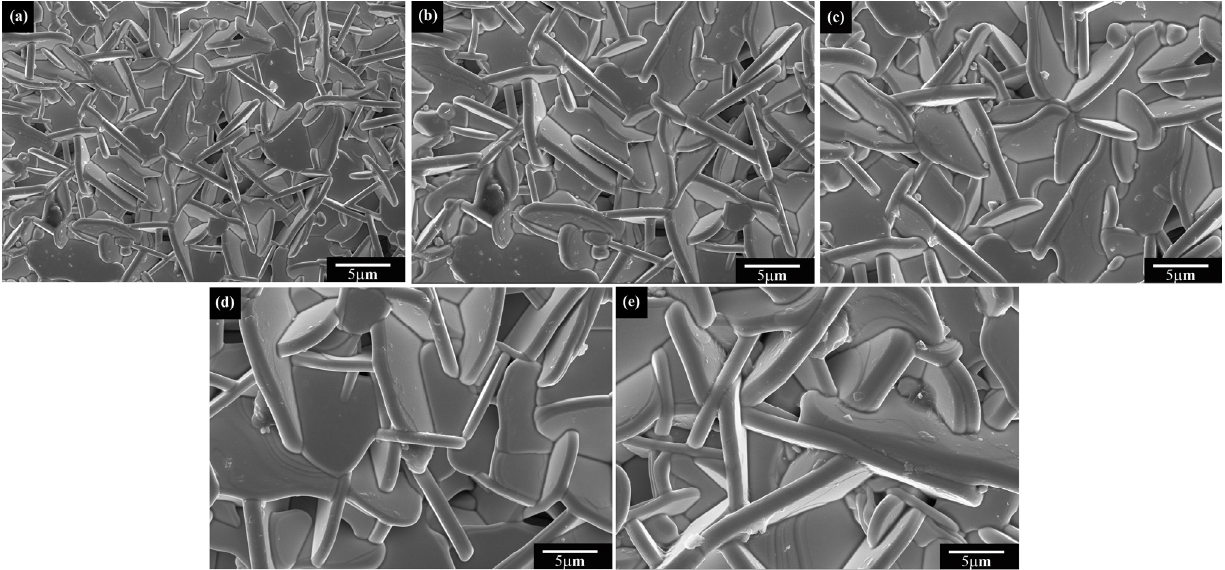
Figure 4. Natural surface SEM images for the Mn/Nb co-doped NBT ceramics sintered at 1100 ◦ C: ( a ) x = 0.00, ( b ) x = 0.01, ( c ) x = 0.02, ( d ) x = 0.03, and ( e ) x =